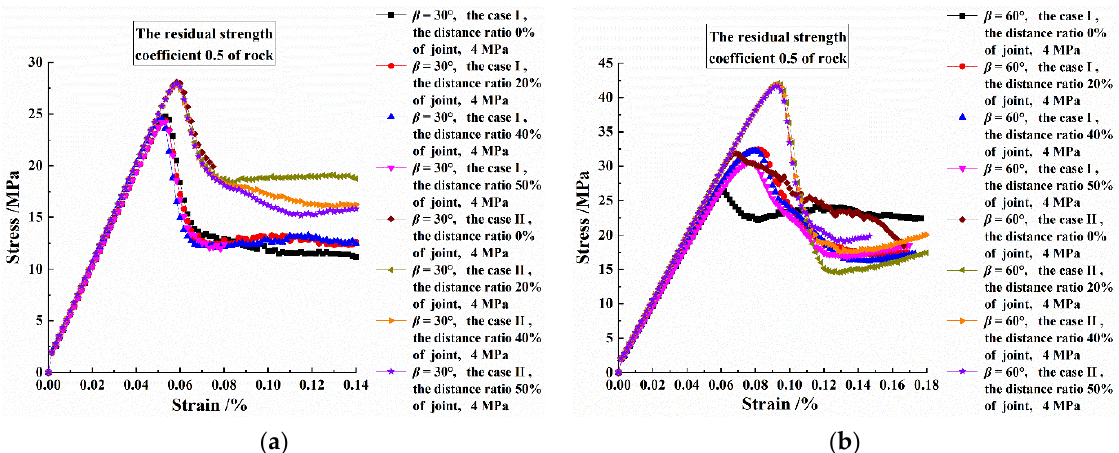
Figure 7. For the two kinds of model boundaries and the loading curves affected by various joint distance ratios: ( a ) for β = 30°; ( b ) for β = 60° (Case Ⅰ corresponding to the case between plane stress and plane strain and Case Ⅱ corresponding to the plane strain).